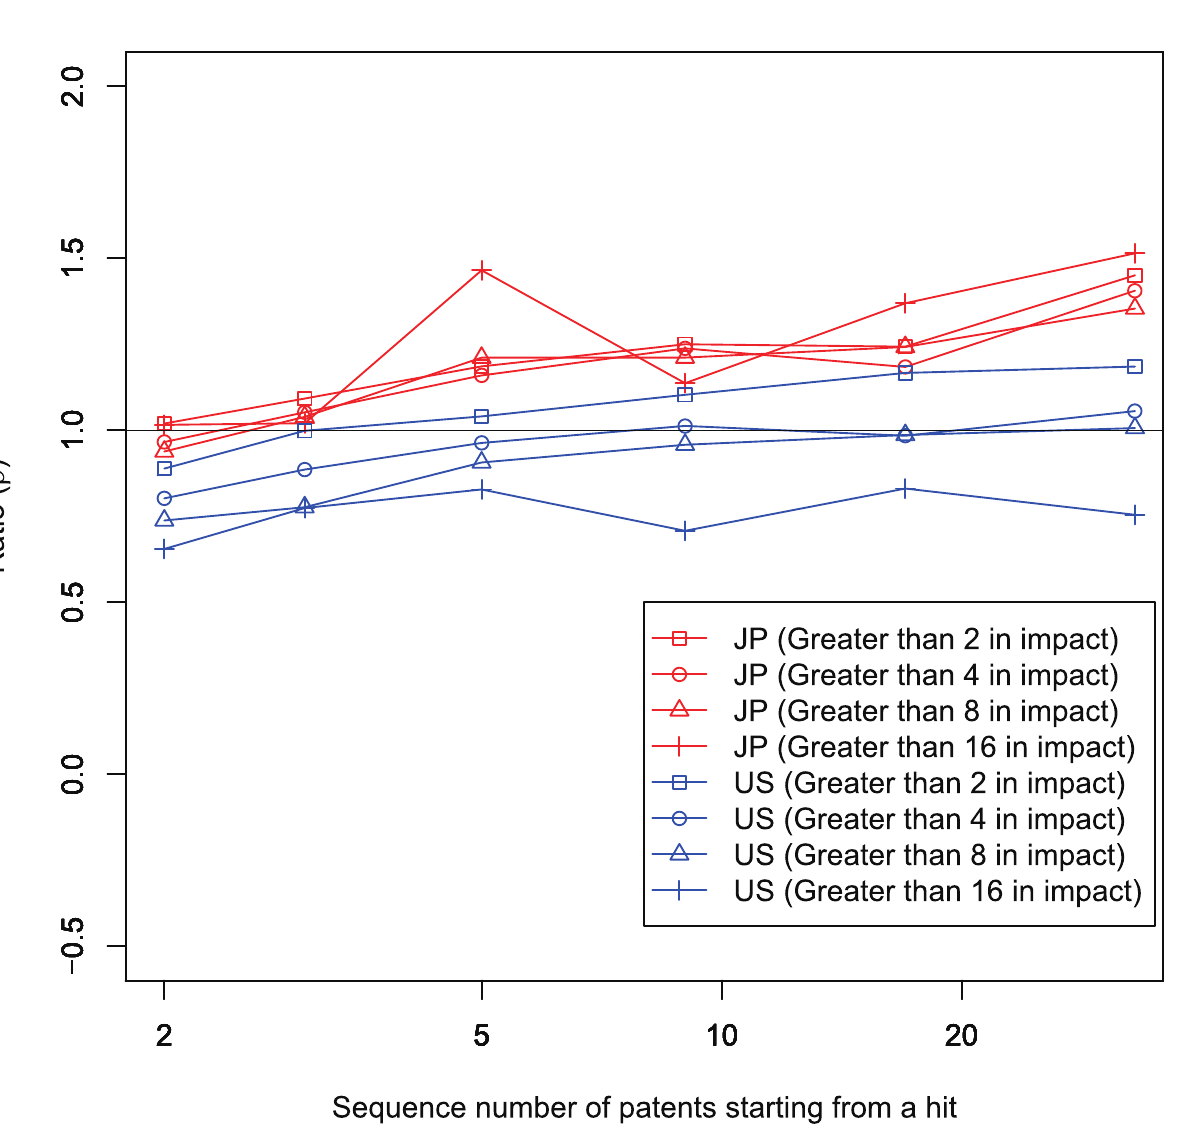
Fig 8. Effect on ρ r of hit threshold. Horizontal axis is number of patents including a hit and all subsequent patents by the same team that made the hit. Vertical axis is ratio ( ρ r). There are four different thresholds of hits in this figure: greater than 2, 4, 8, and 16 in impact. Black horizontal line is ρ =